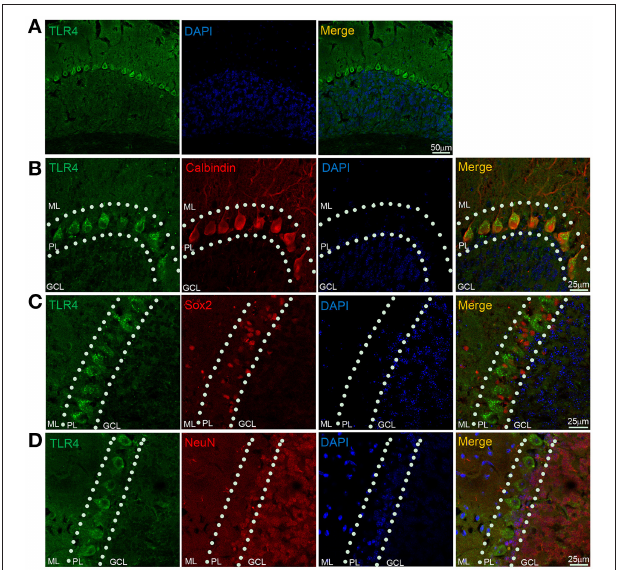
FIGURE 5 | TLR4 is highly expressed in cerebellar PCs. (A) TLR4 expression was detected in the PL. (B) Immunohistochemical analysis of calbindin revealed colocalization with TLR4 in PCs. (C) TLR4 expression was not detected in Sox2-positive BG in the PL. (D) NeuN-positive GCs located in the GCL and PL (dashed lines) did not express TLR4. Scar bar = 50 µ m in (A) , 25 µ m in (B,C,D) . ML, molecular layer; PL, Purkinje cell layer; GCL, granule cell layer.